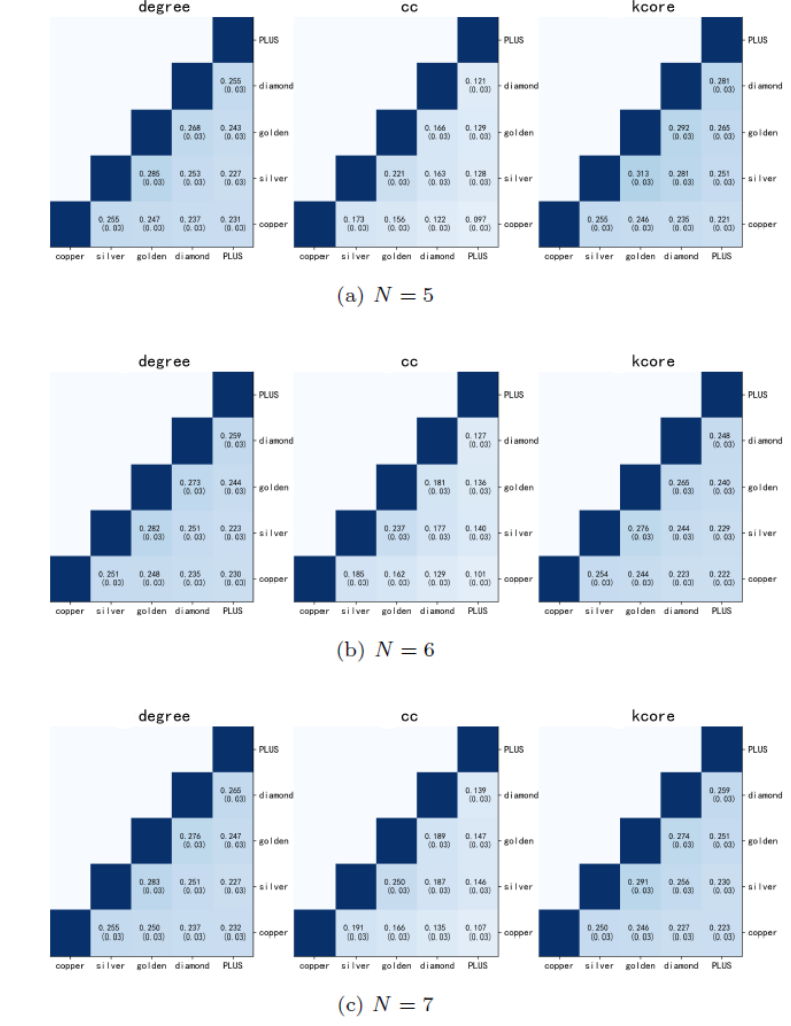
Figure A8. Semantic similarity among the five user levels in the bootstrapping method ( N = 5,6,7). The similarity is measured through the Kendall correlation coefficient of 500 randomly selected words that are repeated 1000 times. The x -axis and y -axis represent five user levels, and the numbers in the patches refer to the average with the standard deviation in brackets behind it. Patches in the grid refer to the similarity between two user levels, with darker colors indicating greater similarity. In addition, the outcomes here illustrate the reliability of the semantic similarity among user